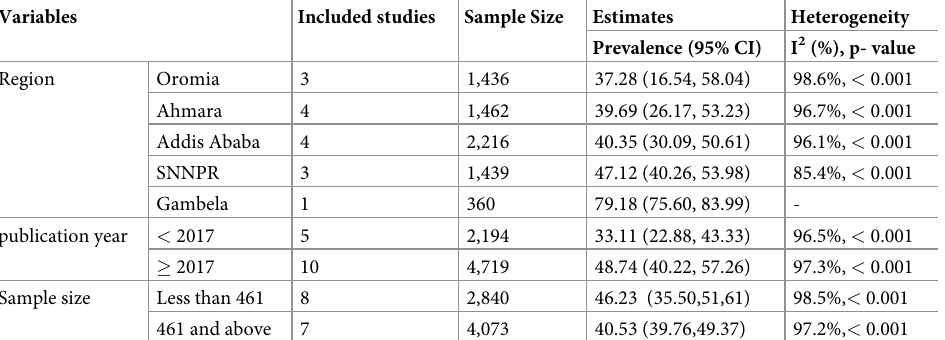
Table 3. Sub-group analysis of the prevalence of the risky sexual practice in Ethiopia based on random effect model, 2021 (n = 15).